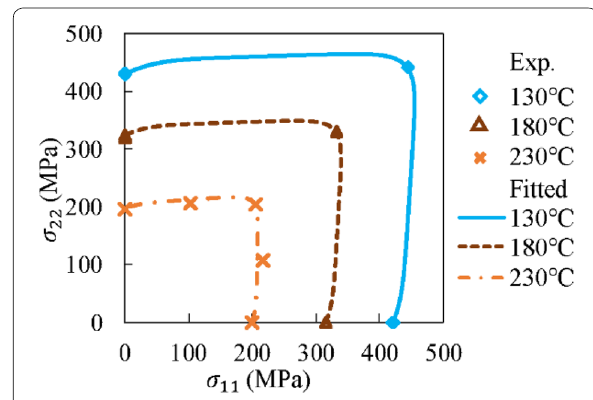
Figure 17 Yld2000-2d theoretical yield loci with exponent factor of 14 ( ε p = 0.01 yield stress and the plastic strain ratio under equi- biaxial tension at various temperatures. (2) Through comparison of experimental results with three yield functions, Yld2000-2d yield function,